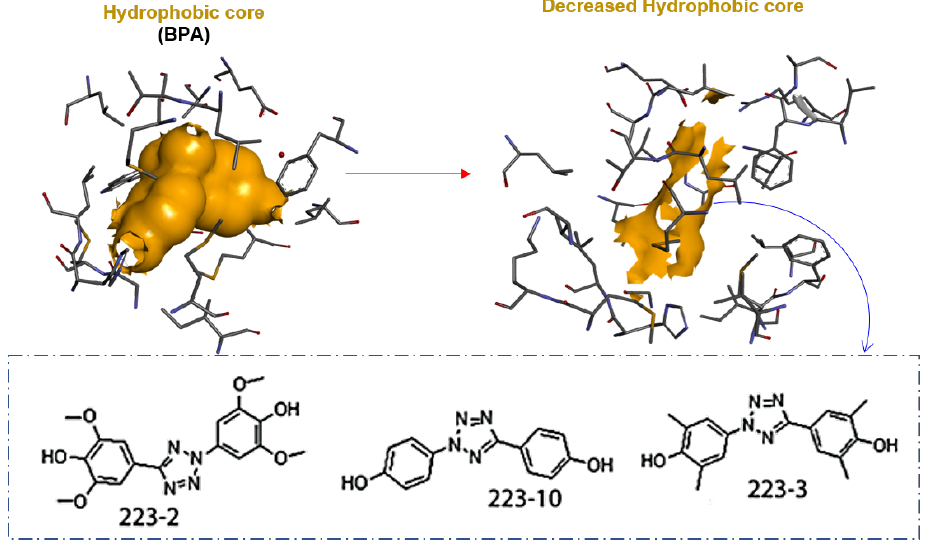
Figure 2. Recent research highlighted that substituting the BPA’s isopropylidene hydrophobic core with the tetrazole core (upper figure) decreased the estrogenicity of bisphenol. For example, two of the designed NCEs with bisphenol structures (223-2 and 223-3) bearing a tetrazole core (lower figure with chemical structures within the dotted rectangle) were potentially non-estrogenic by in vitro studies (Figure S1 of the Supporting Information) and, therefore, a privileged BPA replacement [ ?